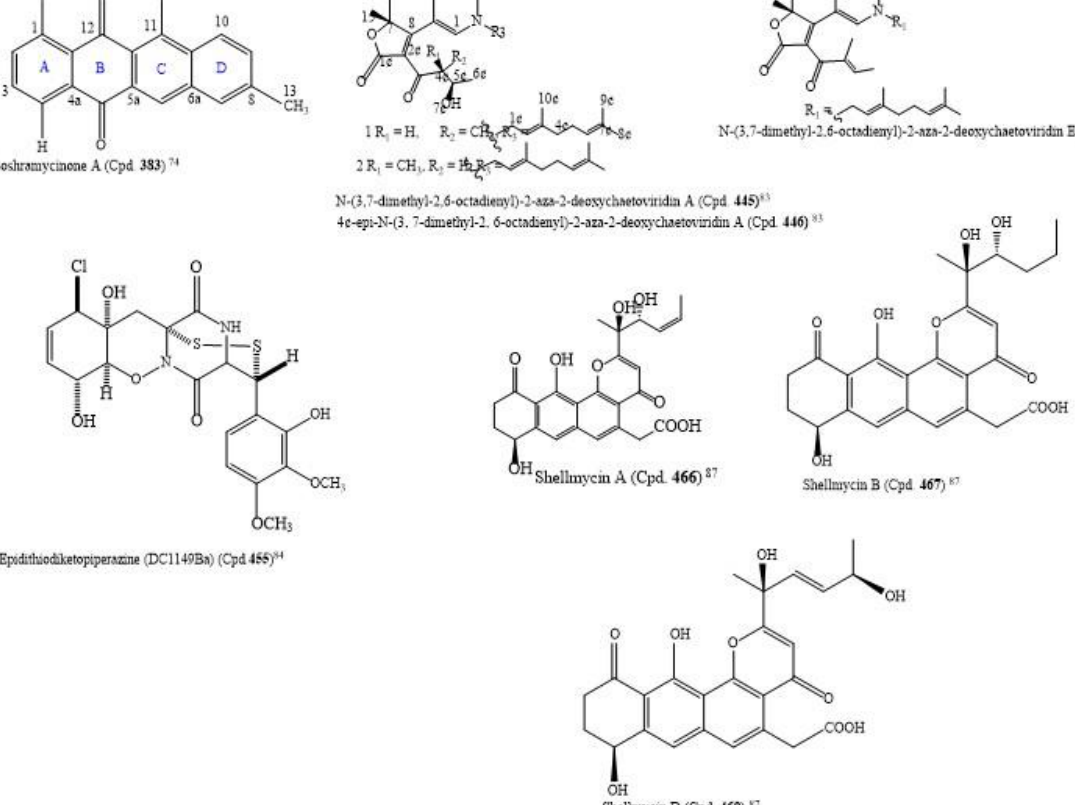
Figure 3. The structures of novel marine-derived amino acid, peptide, and polyketide compounds cytotoxic to cancer cell lines at IC 50 ≤ 1 µM .